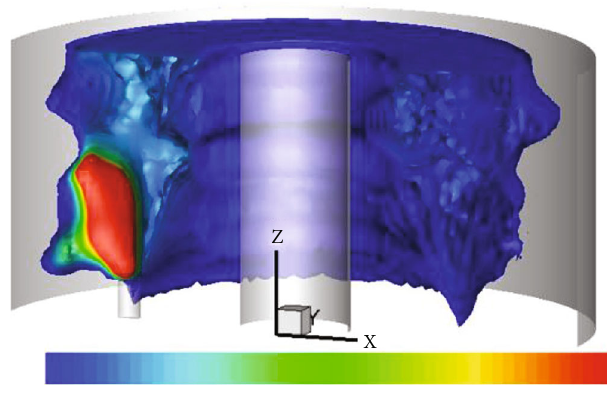
Figure 18: Distribution of Bohm, elasticity, excitation, and ionization collision with 10 times the initial magnetic fi eld strength.